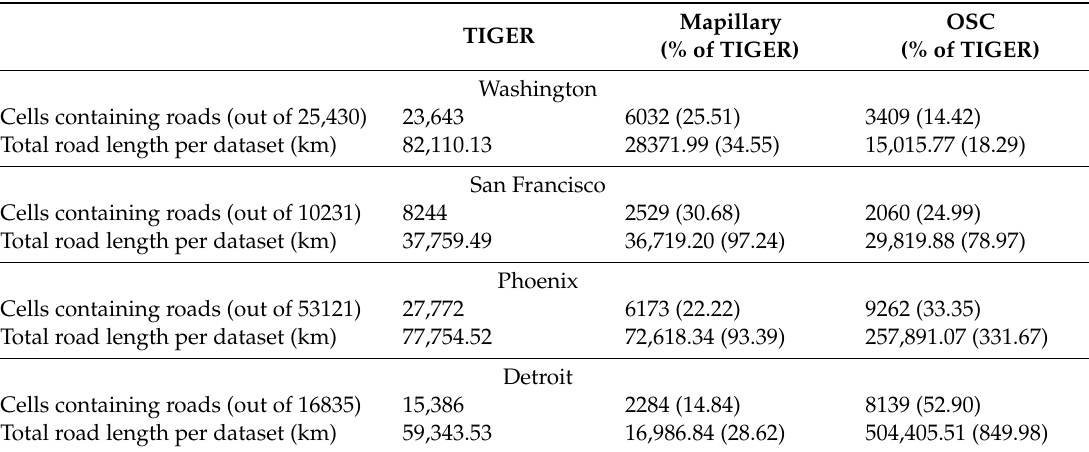
Table 2. Summary road statistics and